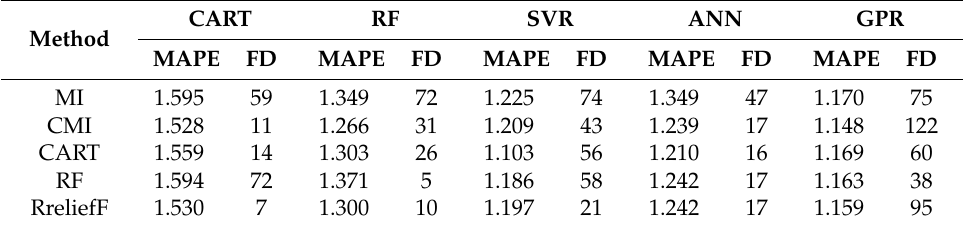
Table 10. Optimal feature subset construction of 1:00 with different methods for